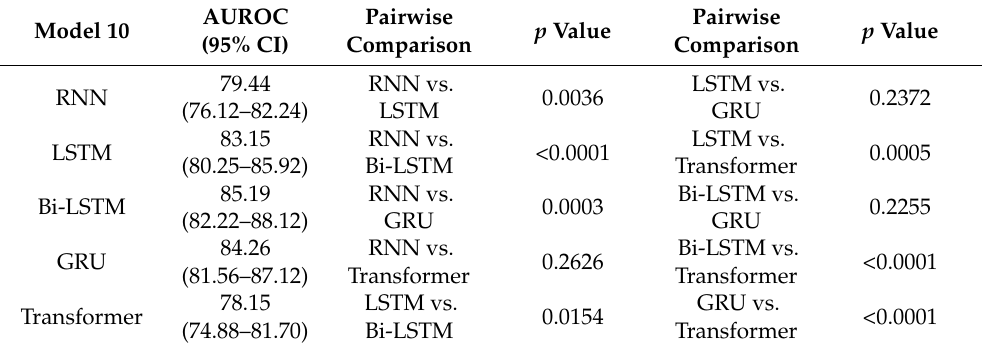
Table 3. Pairwise comparison of AUROC of Model 20 between 5 algorithms.